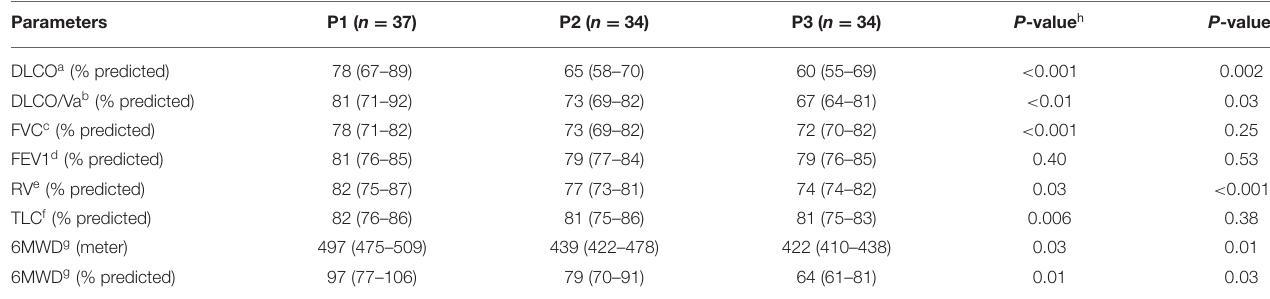
TABLE 2 | Lung function values before the beginning of chemotherapy and during chemotherapy treatment